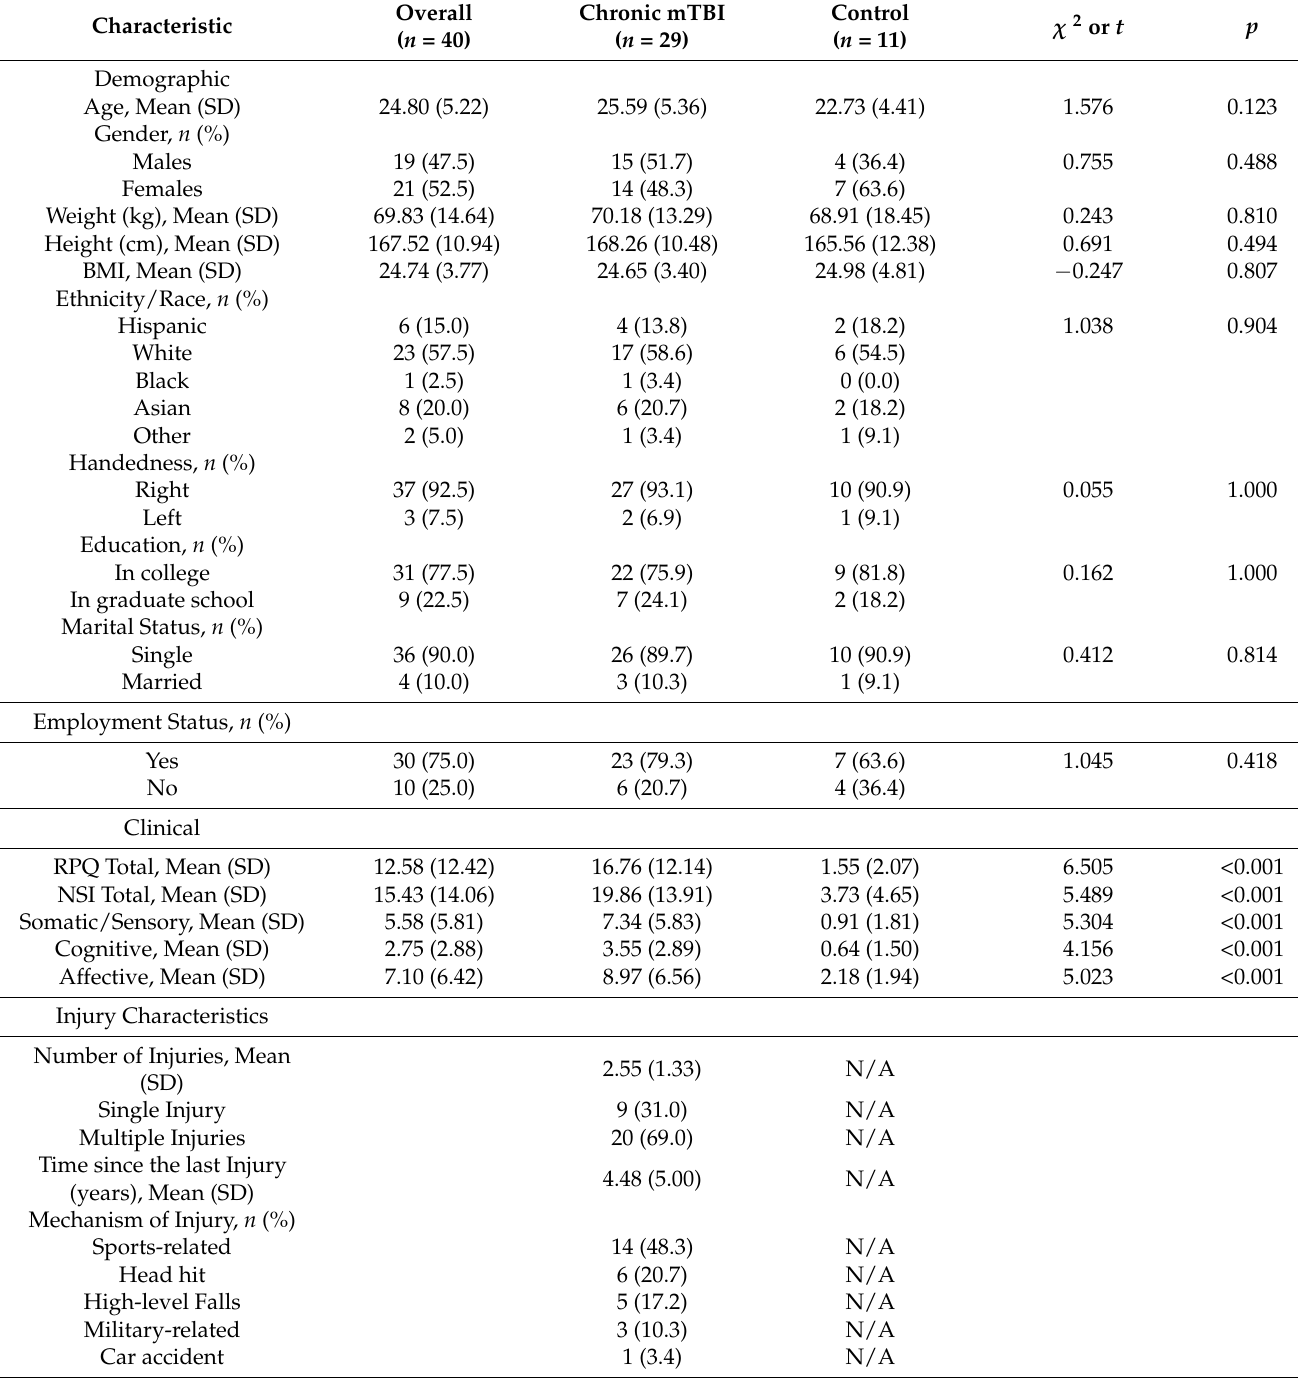
Table 1. Demographic and Clinical Characteristics of Chronic mTBI and Healthy Control Participants ( n =